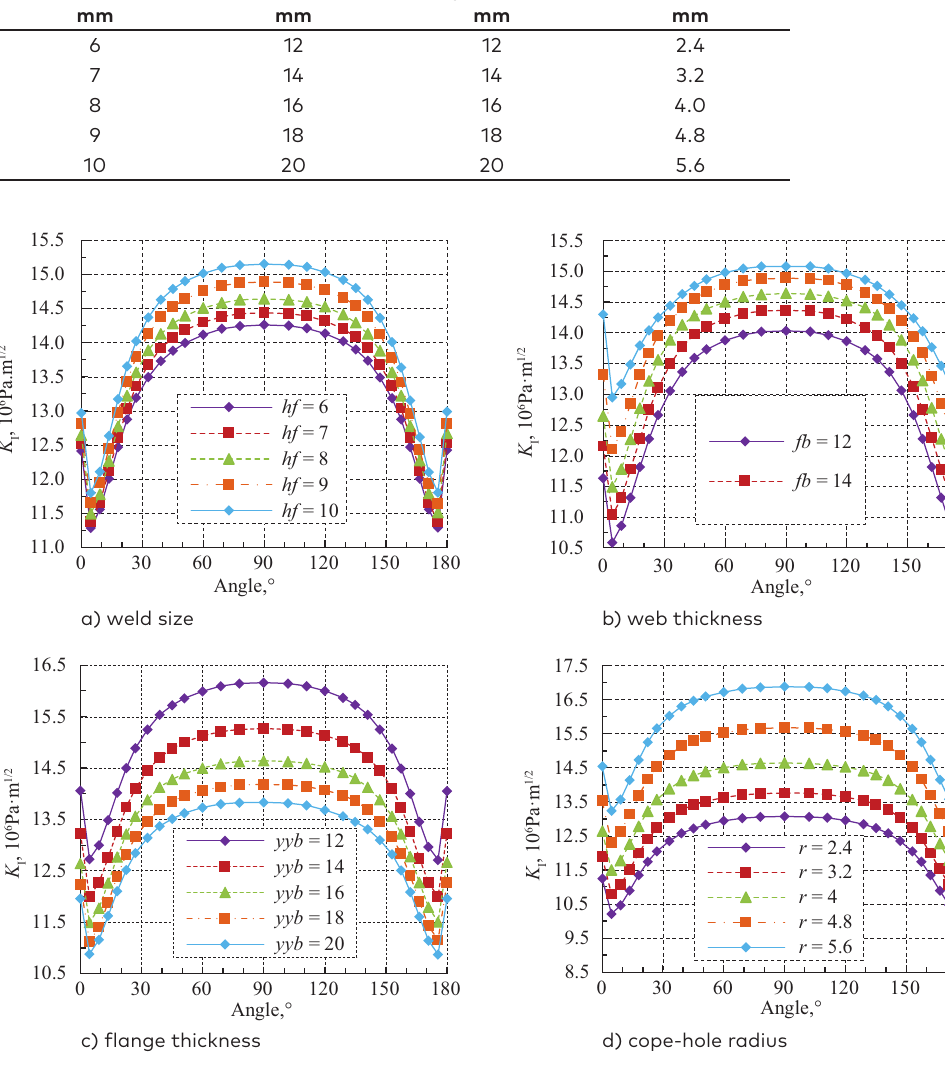
Figure 7. Stress intensity factor affected by different geometric